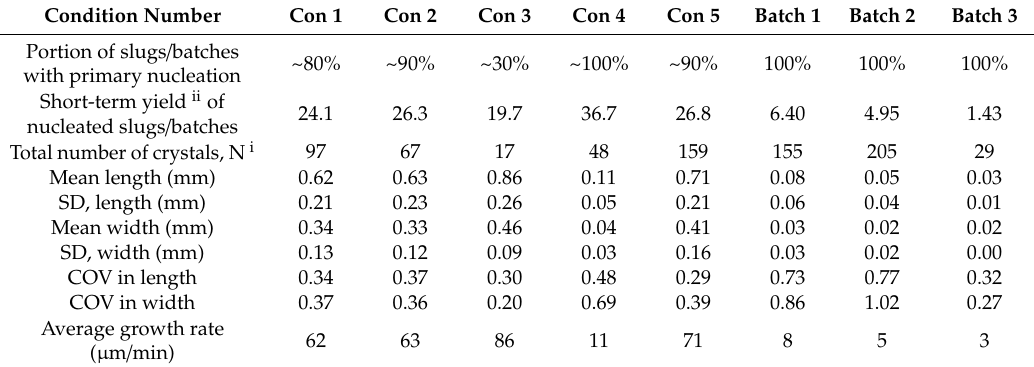
Table 2. Crystal size statistics for cooling crystallization in slug flow and batches. The total number of crystals (N) for statistical analysis is included. Definition of length and width is the same as in the book [34]., and width is perpendicular to the length on the image. For all these crystals, their standard deviation (SD) and the coe ffi cient of variation (COV) of both the length and width are also included here. The average crystal growth rate is estimated by dividing the mean crystal length (for that specific condition) by the growth time of 10